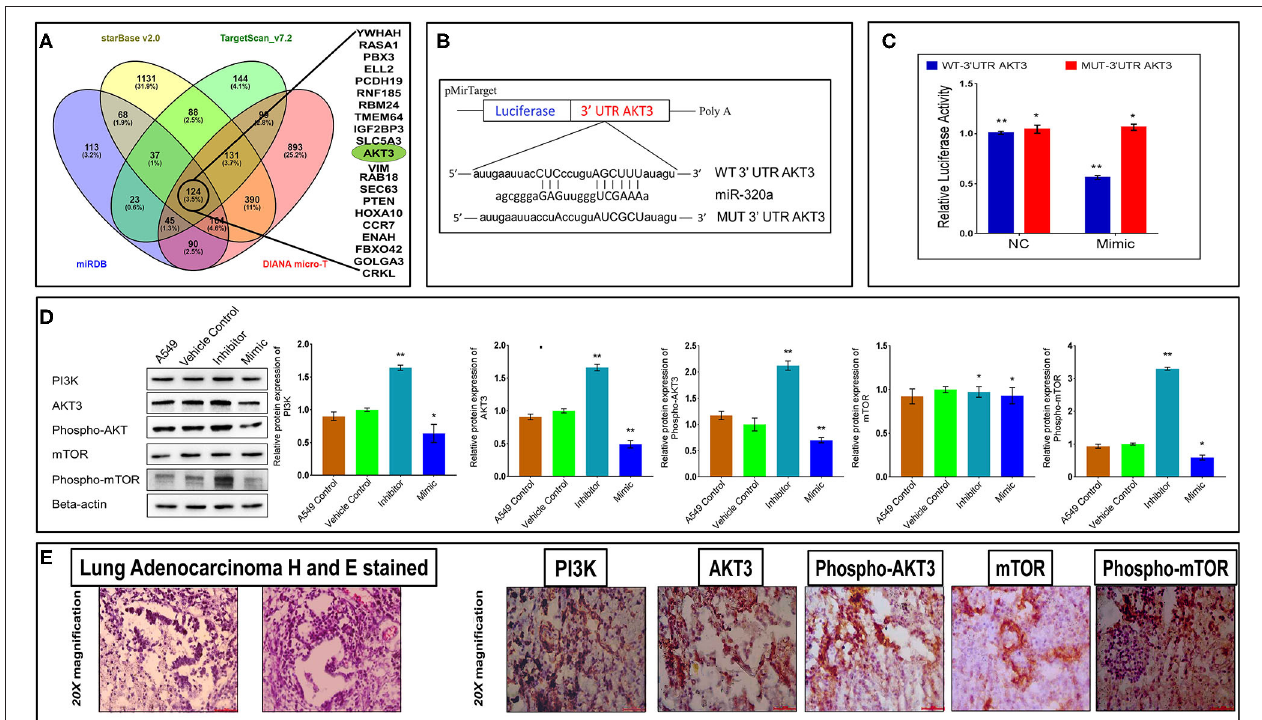
FIGURE 6 | MiR-320a regulates the PI3K/AKT/mTOR pathway through its direct target, AKT3 . (A) MiR-320a in silico target prediction shows 124 common targets (inside black circle) common to databases starBase (peach), miRDB (blue), TargetScan version 7.2 (green), and DIANA micro-T (pink). (B) MiR-320a binding site with AKT3 as predicted by DIANA micro-T, an online computational tool. (C) Dual-luciferase reporter assays show miR-320a regulating AKT3 through direct binding. The data are presented as mean ± SEM from three experiments where * p > 0.05, ** p < 0.05 significant differences from negative control (NC) calculated using paired t -test. (D) Immunoblot assays (a representative blot is shown) were used to determine normalized protein levels of PI3K, AKT3, Phospho-AKT3 (pThr305), mTOR, and Phospho-mTOR (pSer2448) proteins in untransfected A549 cells, A549 cells transfected with the vehicle control, a miR-320a inhibitor (100nM), or mimic (100nM). All experiments were carried out four independent times. The data are presented as mean ± SEM where * p > 0.05, ** p < 0.05 significant differences from vehicle control calculated using paired t -test. (E) Immunohistochemistry images represent tumor cells positive (brown-stained) for PI3K, AKT3, pAKT3, mTOR, and p-mTOR proteins in the cytoplasm of NSCLC patient tissue samples. Scale bar 100 µ m and n = 3 NSCLC